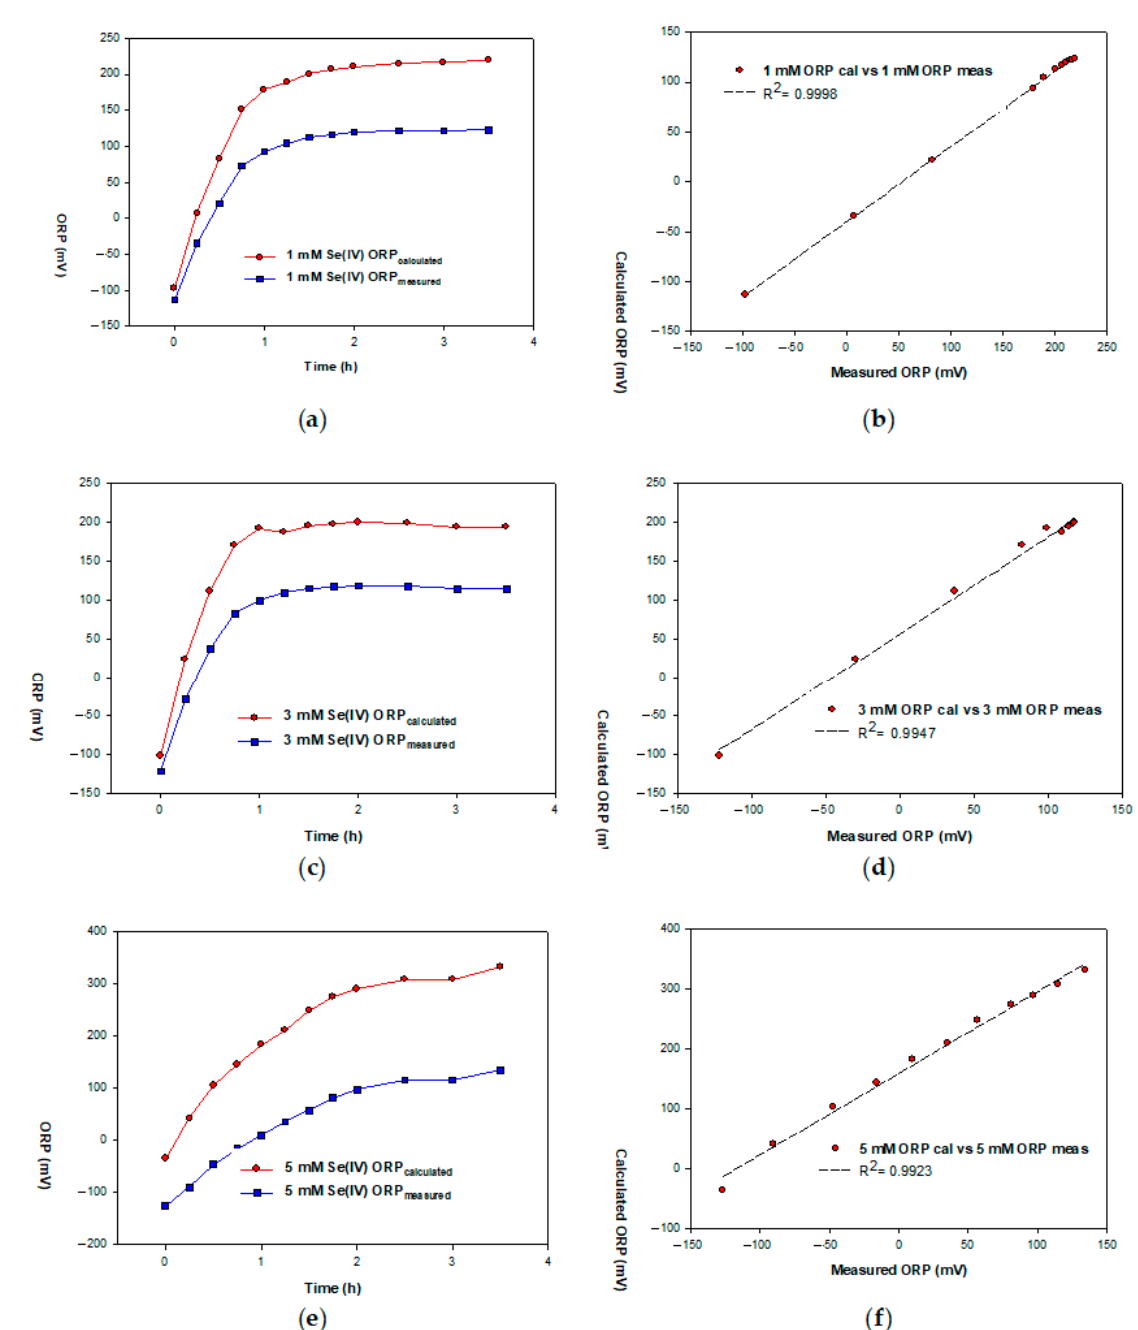
Figure 7. Plots depicting for 1 mM: ( a ) ORP measured and ORP calculated vs. time and ( b ) correlation for ORP measured vs. ORP calculated ; for 3 mM: ( c ) ORP measured and ORP calculated vs. time and ( d ) correlation for ORP measured vs. ORP calculated ; and for 5 mM: ( e ) ORP measured and ORP calculated vs. time and ( f ) correlation for ORP measured vs. ORP calculated .